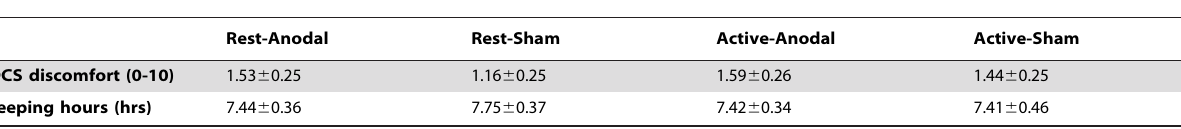
Table 4. tDCS discomfort score and sleeping